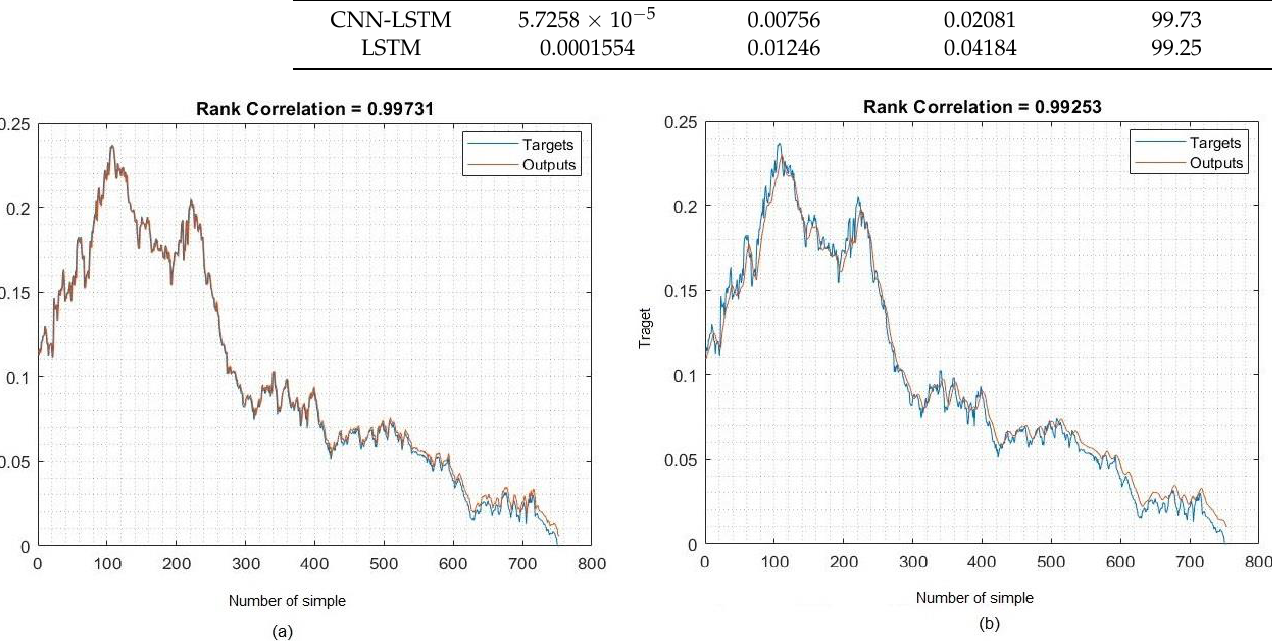
Figure 12. Rank correlation of the deep learning models ( a ) CNN-LSTM and ( b ) LSTM for predicting the Apple stock market closing price during the testing phase. Table 5. Deep learning results for predicting the closing price of Apple during the testing phase.